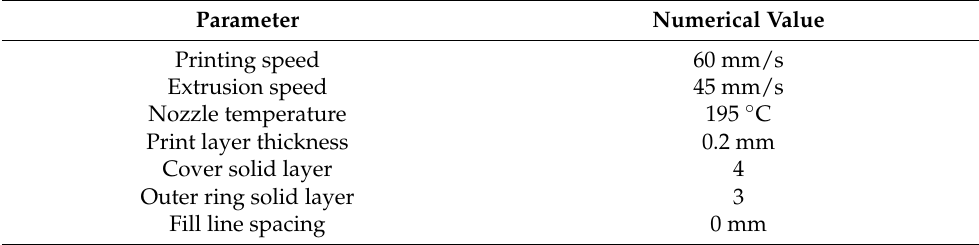
Figure 1. Mechanical sample model, ( a ) tensile sample, ( b ) bending sample . Table 3. Printing Table 3. Printing parameters .